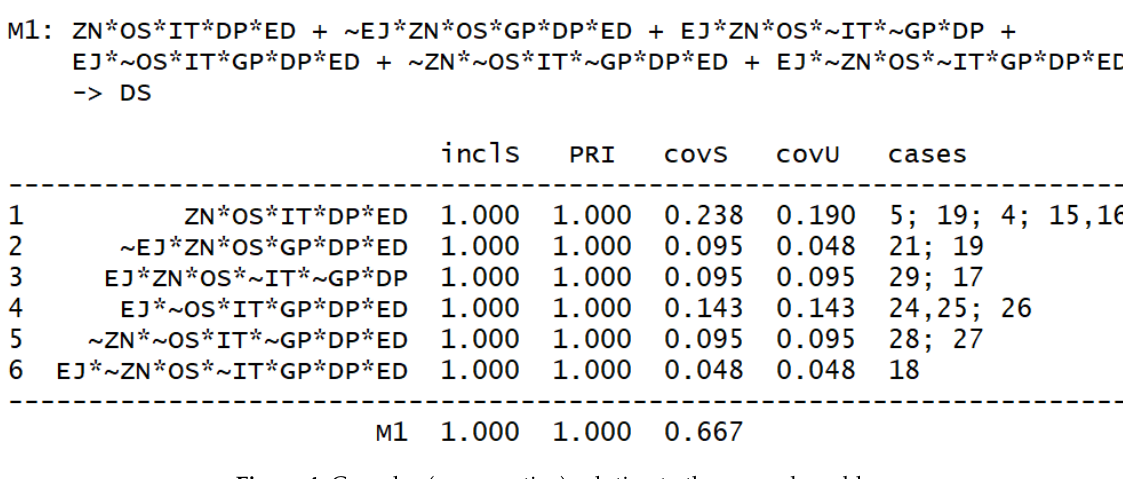
Figure 4. Complex (conservative) solution to the research problem.